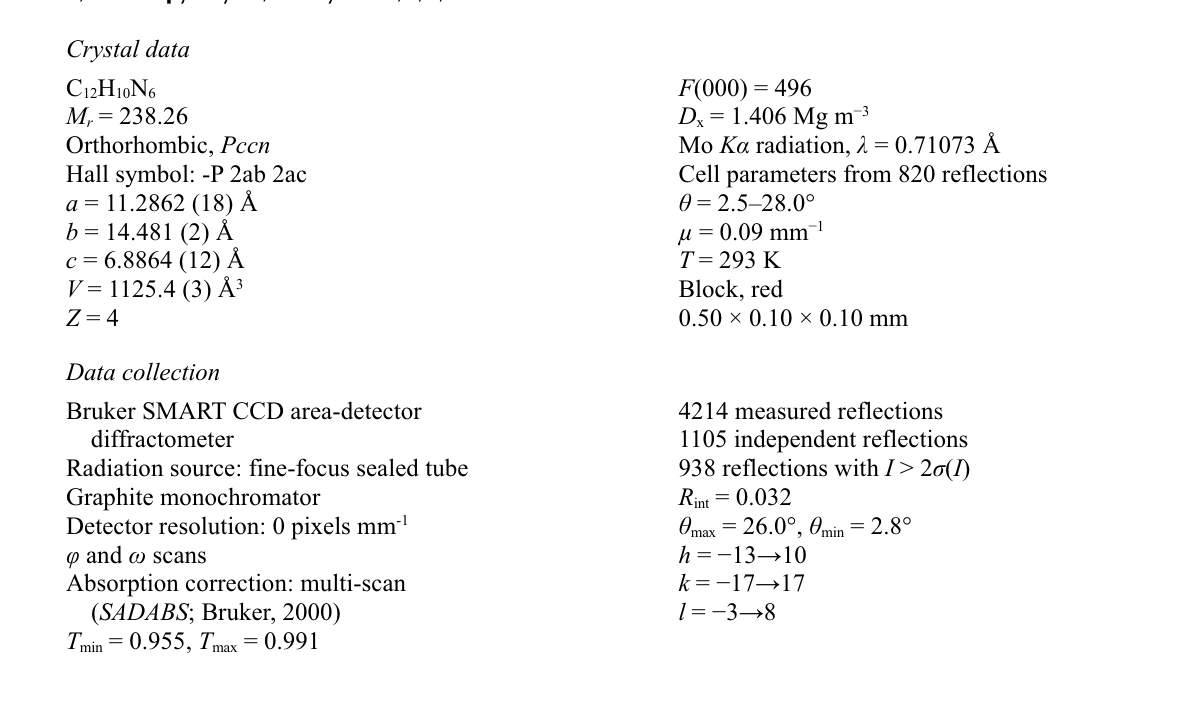
Figure 2 A two-dimensional (4,4) hydrogen-bond network of the title compound viewed along the c axis